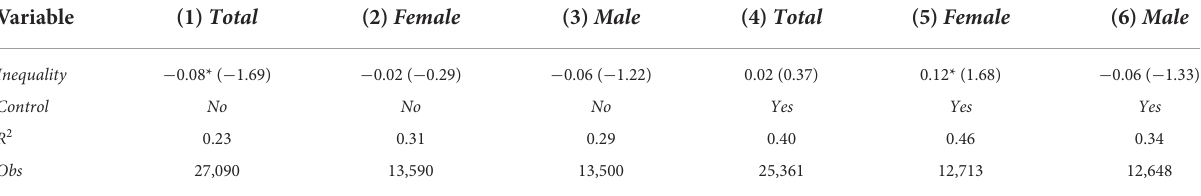
TABLE 7 Status inequality and housework